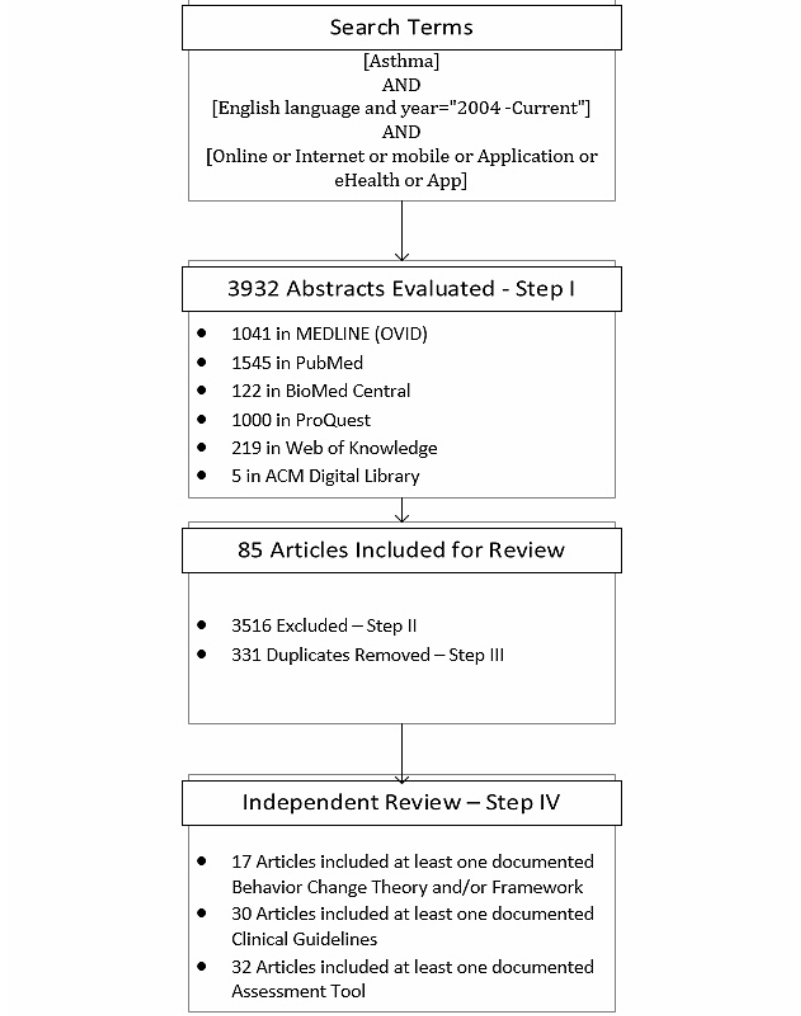
Figure 1. Search results from the six bibliographic